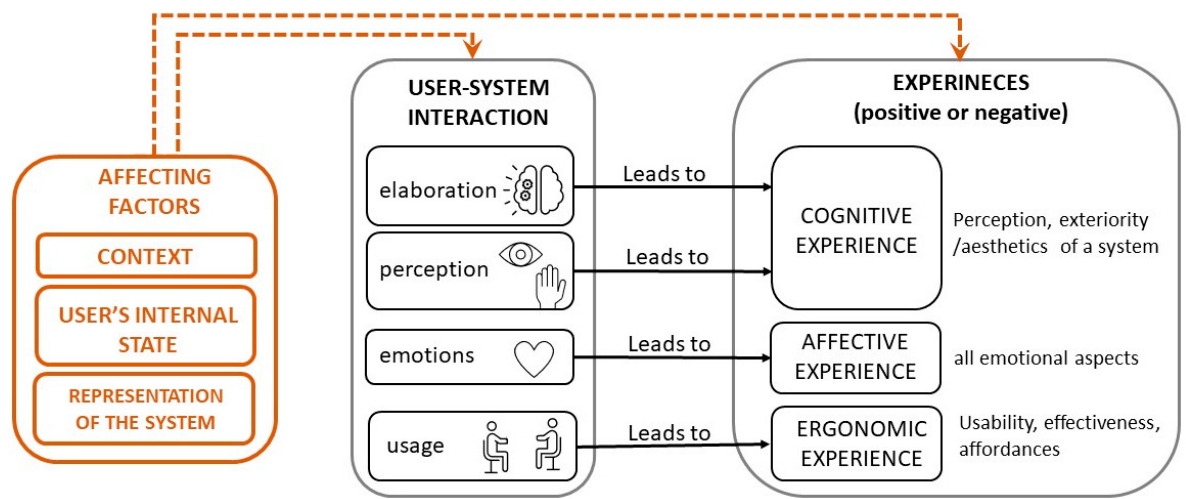
Figure 8. Representation of user-system interactions, the derived different experiences (cognitive, affective, and ergonomic) and the influence factors that affect the overall UX.